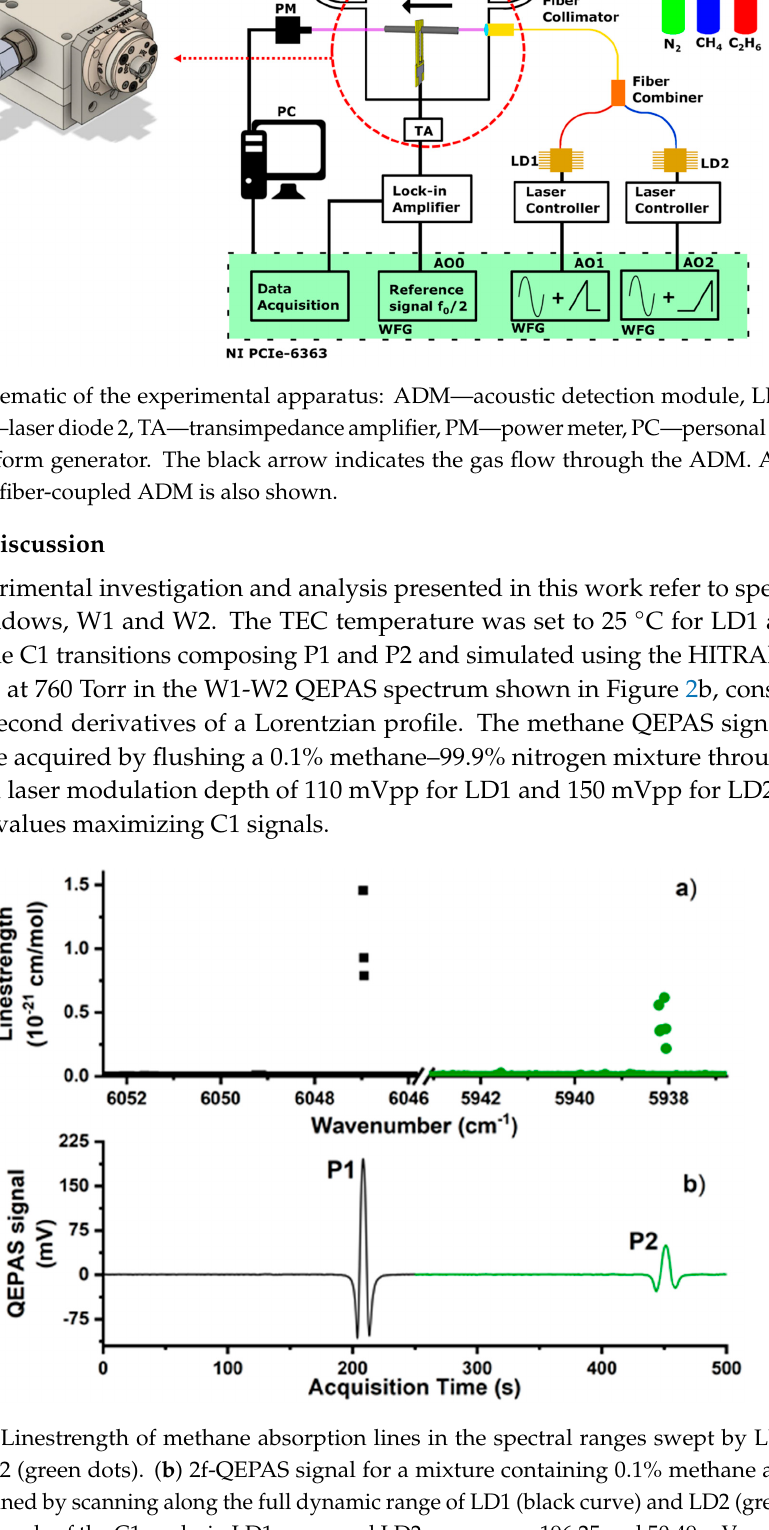
Figure 3. 2f-QEPAS signal for a mixture containing 1% ethane and 99% nitrogen. The black curve was obtained by sweeping the full dynamic range of LD1, and the green curve was obtained by sweeping the full dynamic range of LD2.